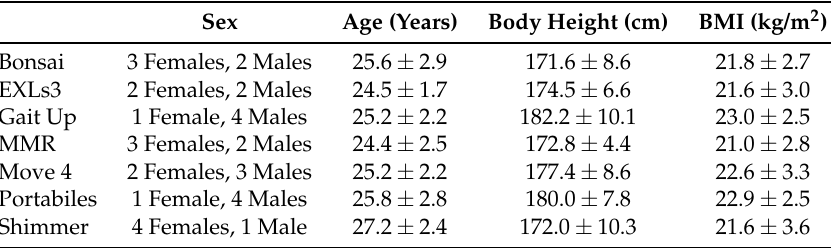
Table 5. Subject characteristics for each of the tested IMU.